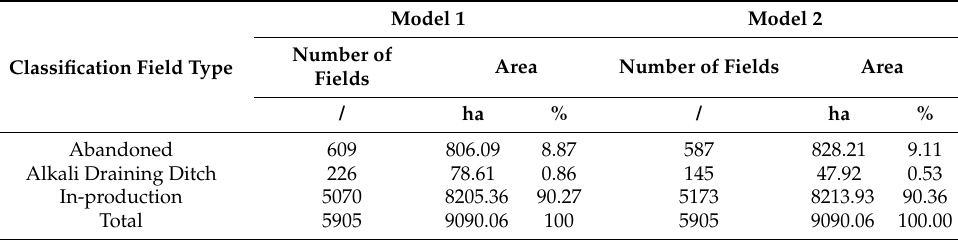
Table 6. Estimated number of fields and areas from the classification results of Models 1 and 2.